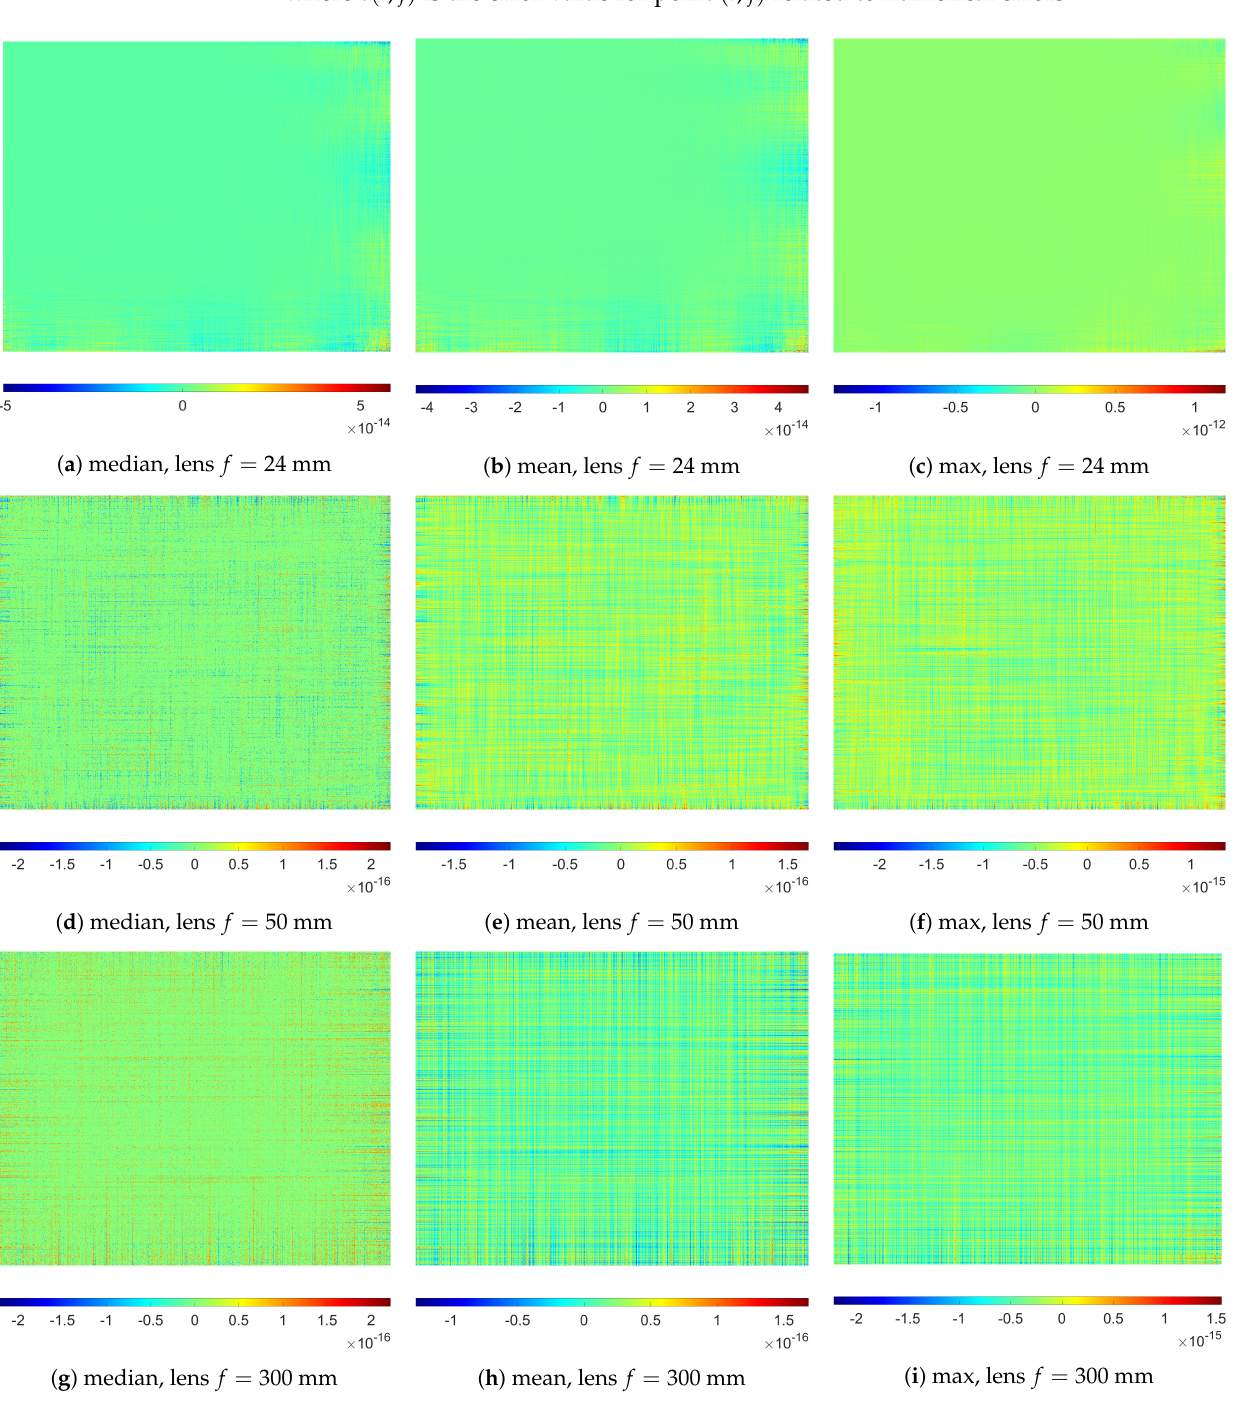
Figure 4. Errors related to using SNILP model with different sequence of approximation directions, examples for images I V of resolution 1280 × 1024 pixels contained with Gaussian mixture noise (A5) for σ add = 5% and σ multi =